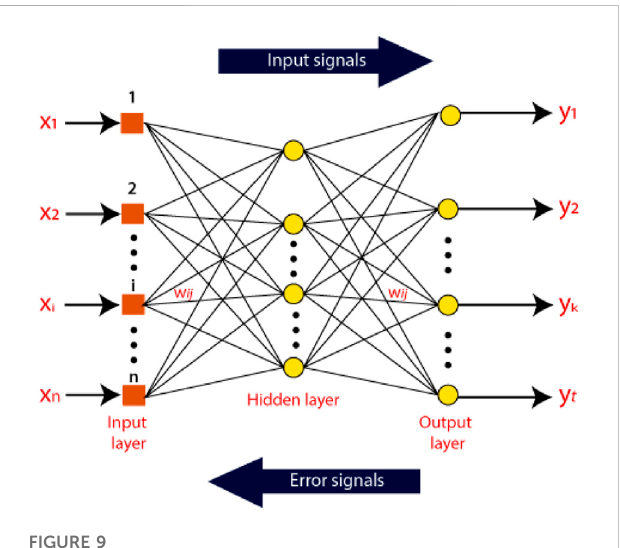
FIGURE 9 ANN structure. Adapted from (Javapoint,